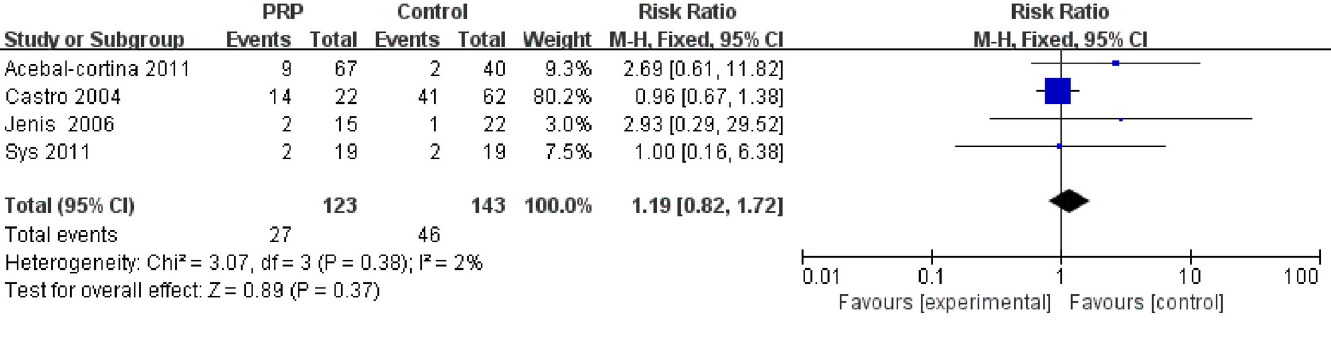
Fig 5. Forest plot of pseudarthrosis in the included